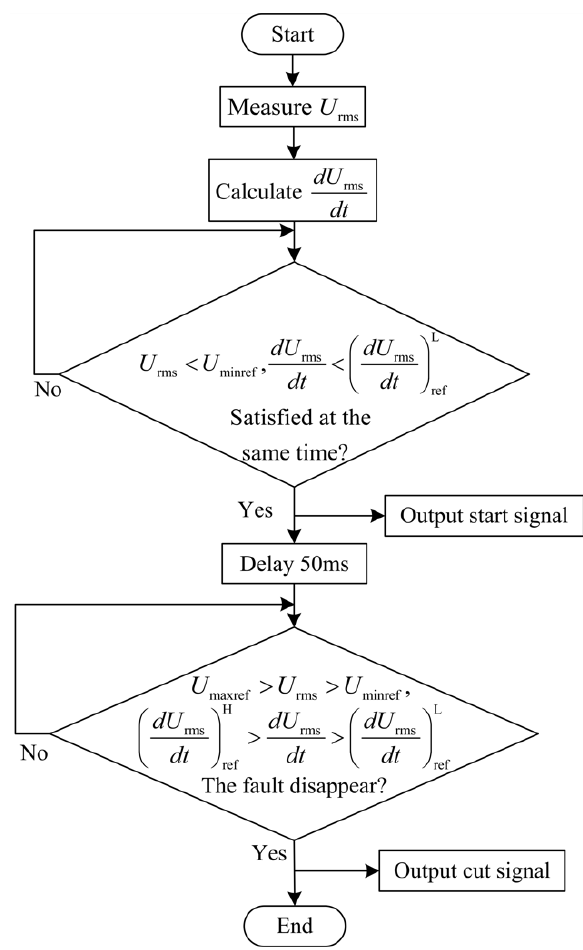
Fig. 9. Fault judgment logic